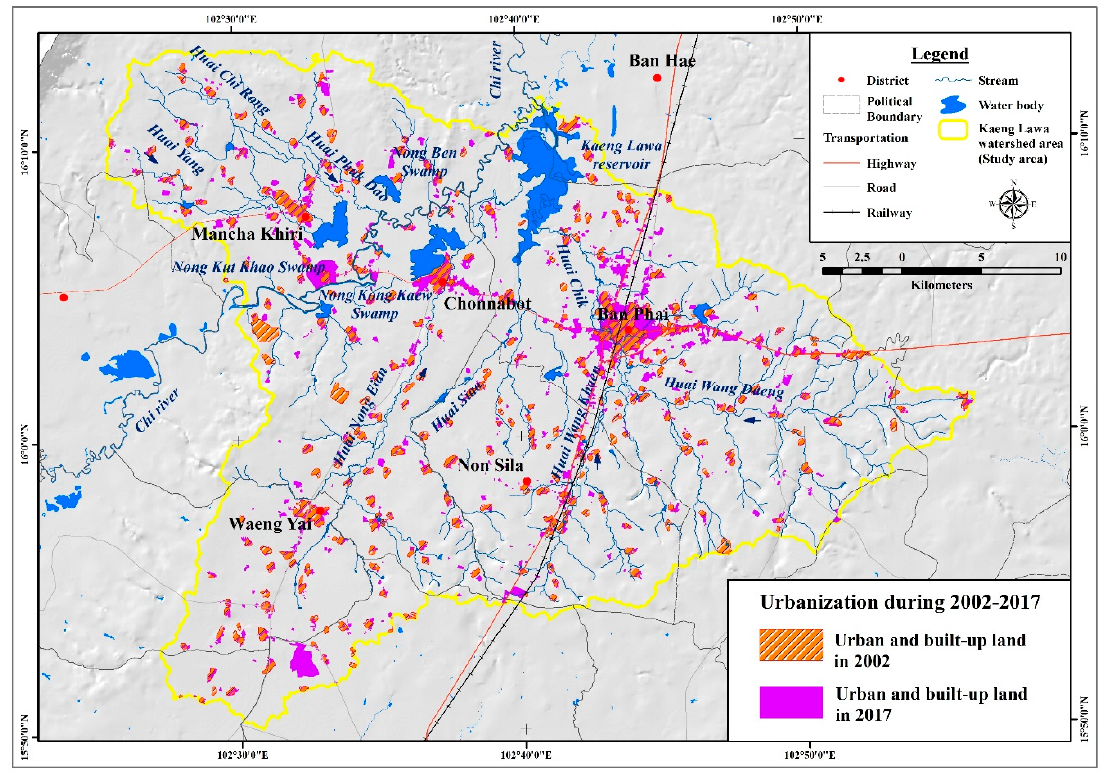
Figure 8. Urbanization during 2002–2017 in KLs area, Khon Kaen Province.